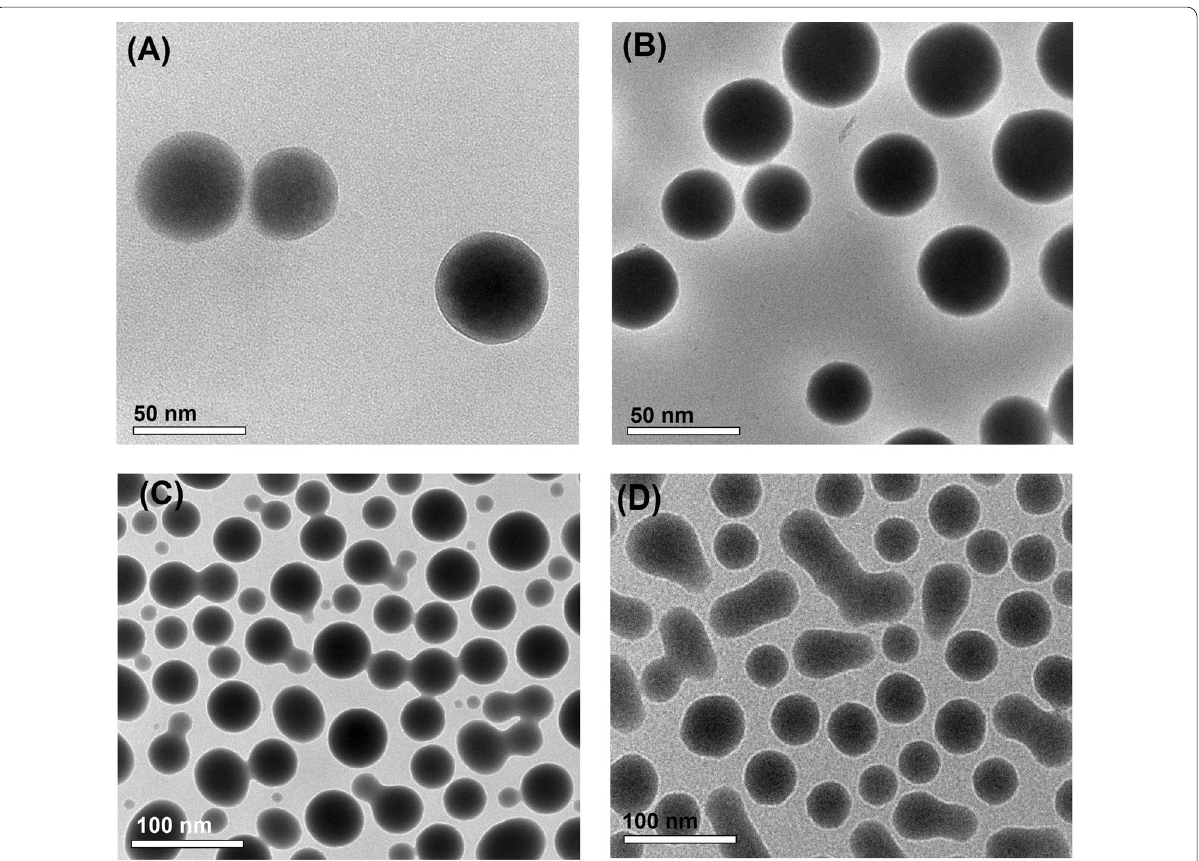
Fig. 4 High Resolution TEM analyses of SeNPs. A TEM micrograph of SeNPs synthesized by A. quadrilineatus , B TEM micrograph of SeNPs synthesized by A. ochraceus , C TEM micrograph of SeNPs synthesized by A. terreus , and D TEM micrograph of SeNPs synthesized by F.